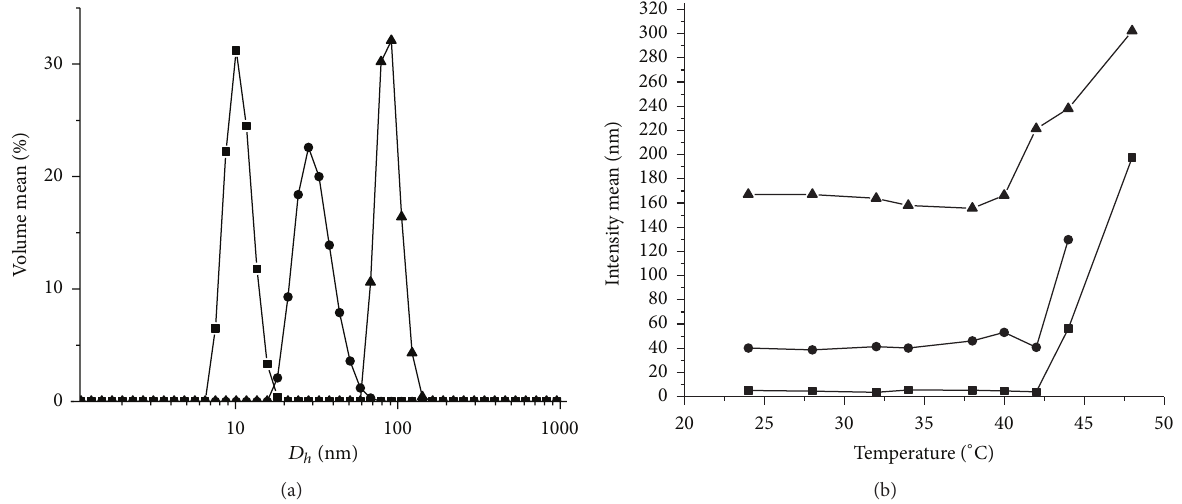
Figure 4: DLS results in PBS at pH 7.4: (a) hydrodynamic diameters at 20 ∘ C, (b) light scattering intensity as a function of temperature. Symbols disclosure: poly(NIPAAm- co -4MBA 5 and star polymer [poly(NIPAAm- co -4MBA 5